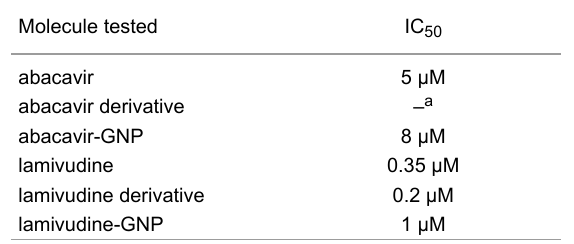
Table 1: Antiviral activity of tested molecules calculated as IC 50 from the cellular